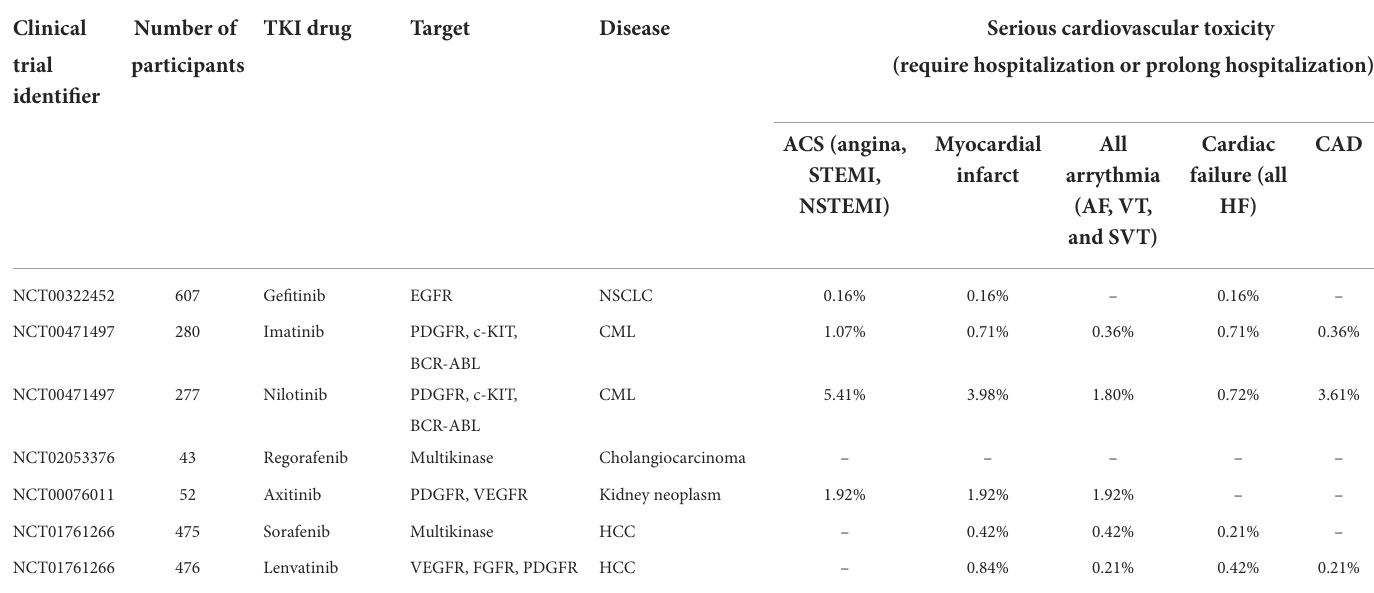
TABLE 1 The adverse effects of TKIs on the cardiovascular